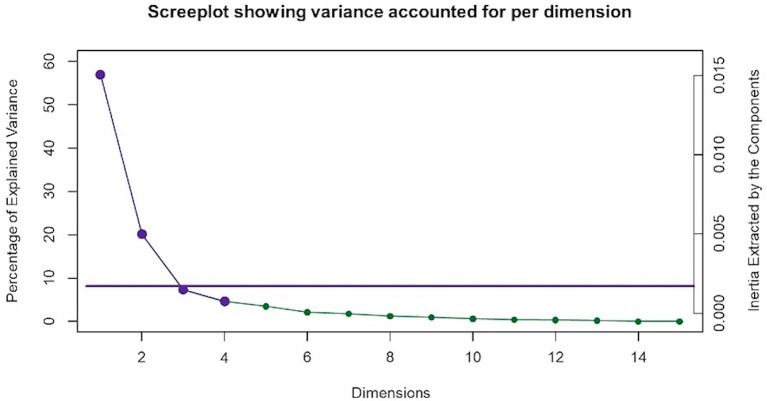
Multiple correspondence analysis (MCA) screeplot. MCA identified four significant dimensions accounting for a combined total of 89% of the variance. The screeplot shows two statistically significant dimensions (dimensions 1 and 2) that survived the Kaiser line test and accounted for 77% of the variance. The purple Kaiser line is a visual representation of the “screetest.”